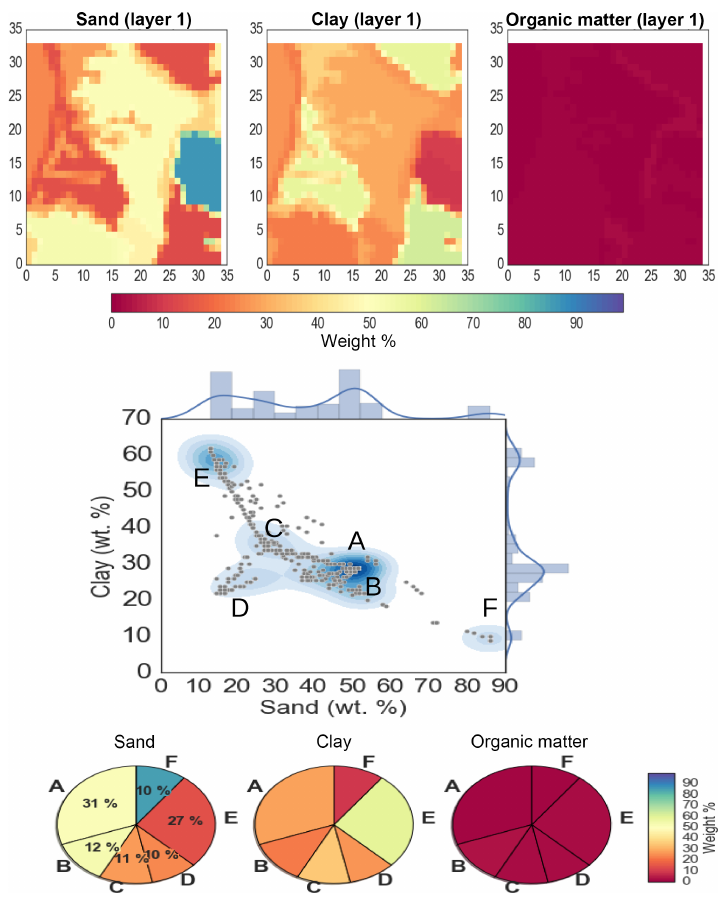
Figure A2. Similar to Fig. 2 for a grid cell in Paraguay. This figure demonstrates the clustering performance for a grid cell with a more heterogeneous soil texture. The clustering algorithm found six clusters for this grid cell. The clusters are labelled A through F in the bottom pie chart and the middle scatter plot. In the scatter plot, the label is placed close to the cluster value to help illustrate the cluster relation in sand–clay